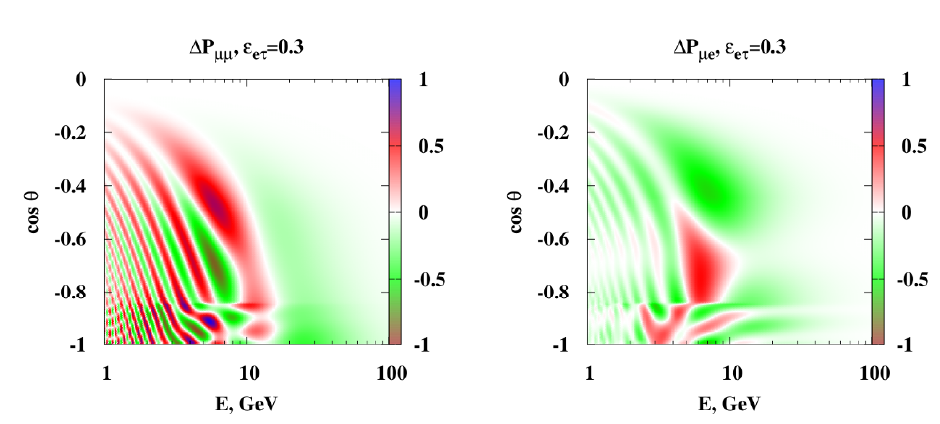
Figure 1 . Di(cid:11)erences between probabilities (cid:1) P (cid:22)(cid:22) (cid:17) P NSI P NSI (cid:0) P noNSI (right panel) shown in color as functions of E and cos (cid:18) . The probabilities are (cid:23) (cid:22) ! (cid:23) e (cid:23) (cid:22) ! (cid:23) e calculated with (cid:15) e(cid:28) = 0 : 3 assuming sin 2 (cid:18) 23 = 0 : 51 and (cid:1) m 2